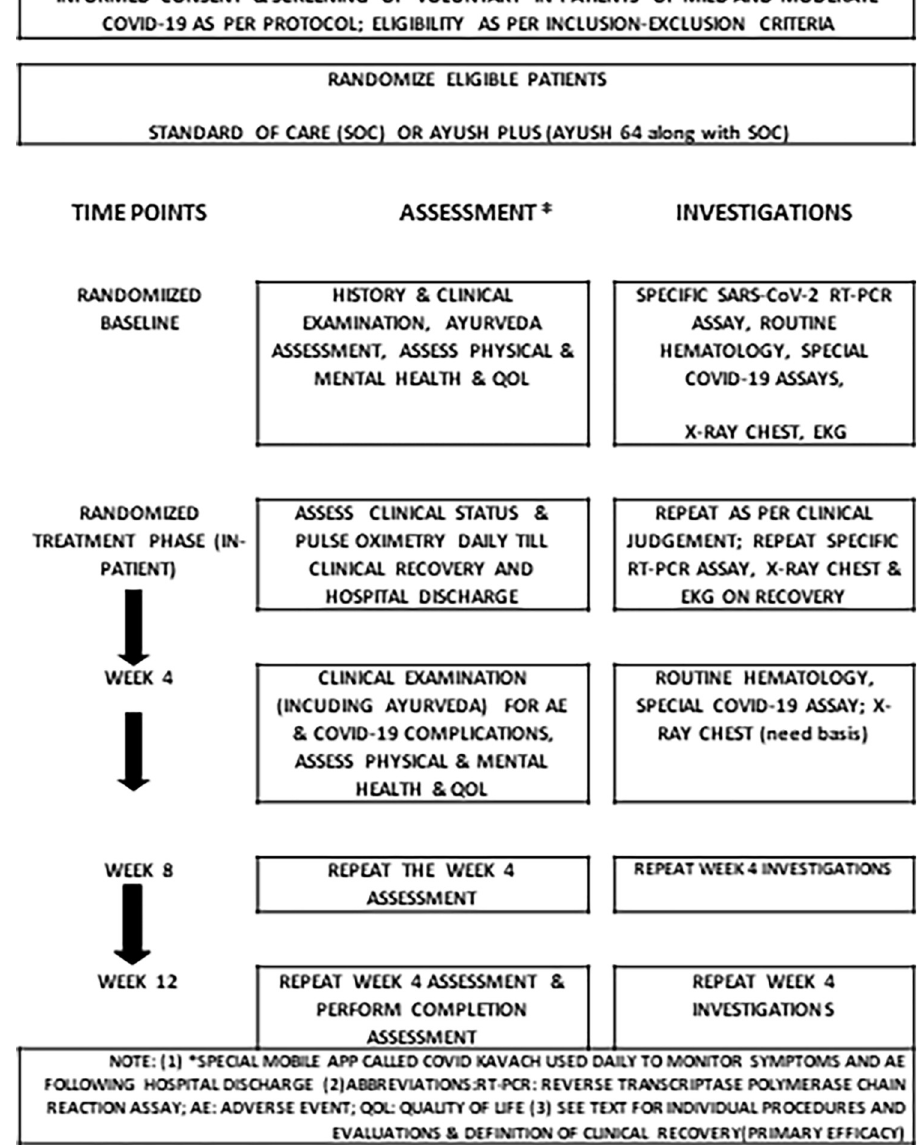
Fig 1. Study flow diagram showing study events and